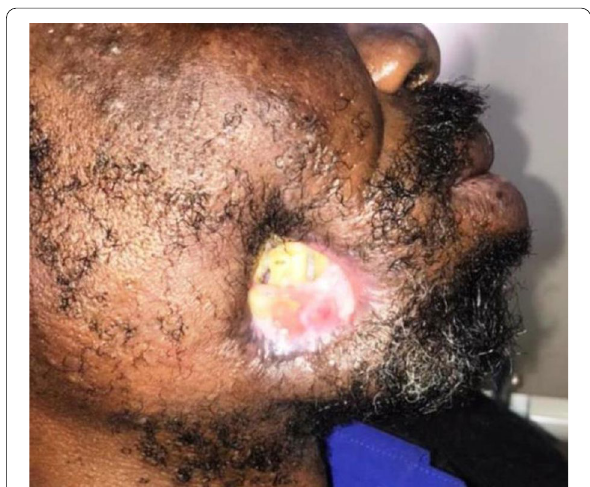
Fig. 5 Arrested noma in a mature HIV-seropositive male, about 9 months after acute noma of cheek, before reconstructive surgery. The whitish material is food and tissue